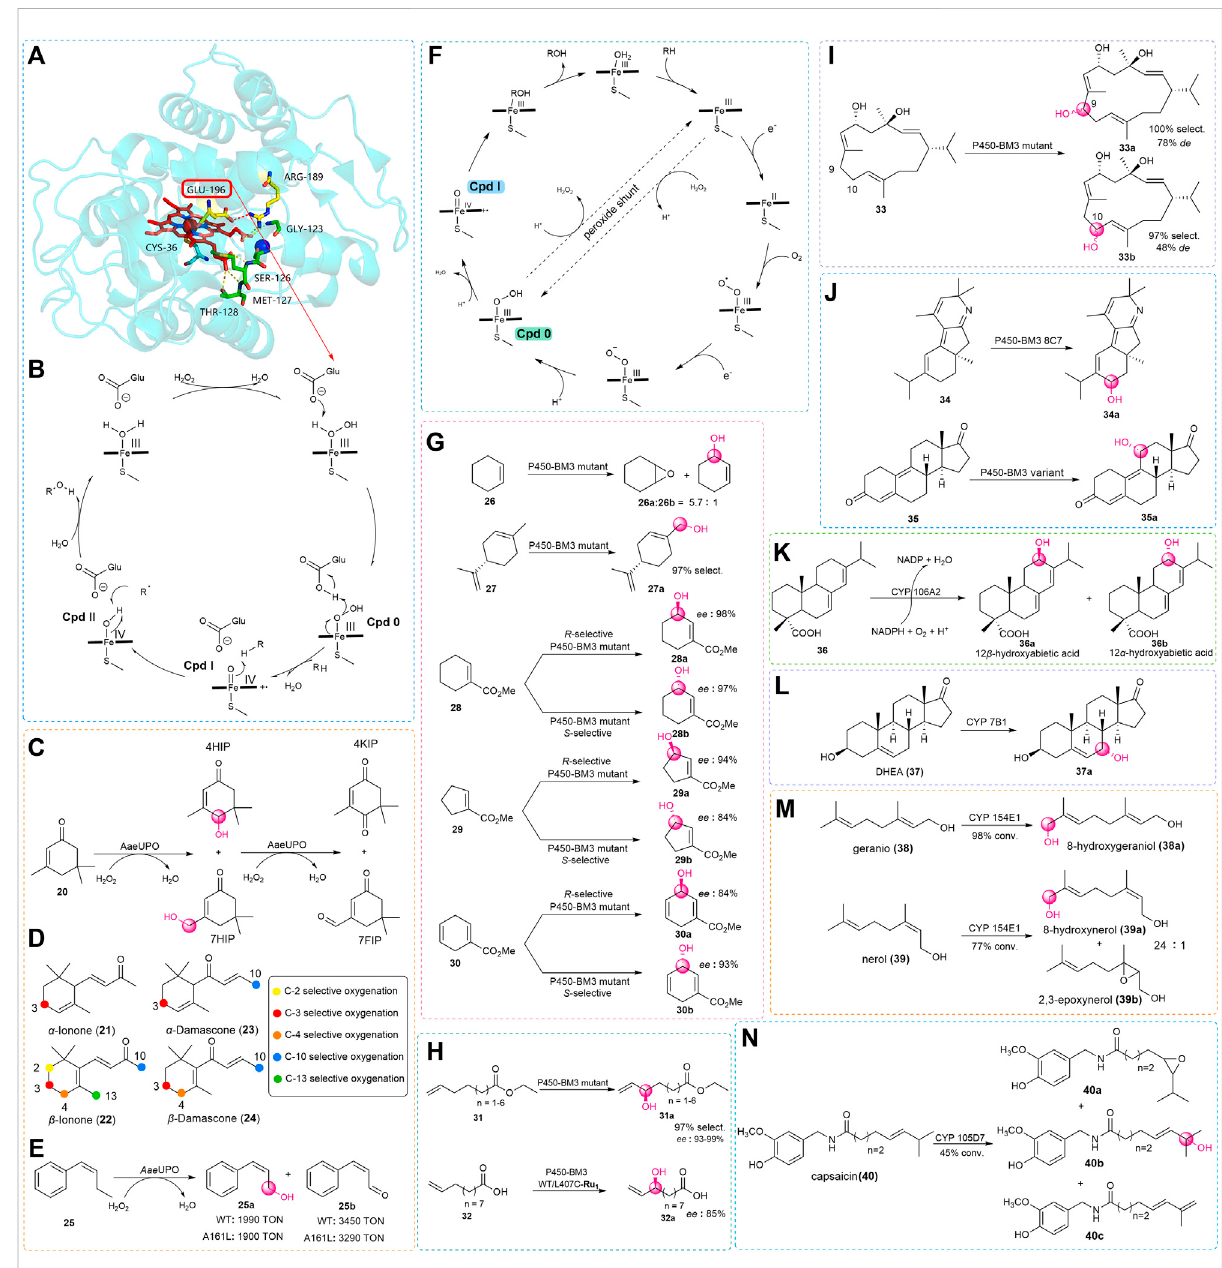
FIGURE 2 (A) Overall crystal structure of Aae APO (Wang et al., 2017). (B) Catalytic mechanism of Aae APO. (C) Isophorone hydroxylation and hyperoxidation catalyzed by Aae UPO. (D) Different colors indicate the positions where the substrate may be hydroxylated during UPO catalysis, obtaining the different oxygenatedderivatives. (E) Bioconversionofthe Mth UPOmutantA161Lgainstheallylicoxidationproducts. (F) OxidationreactionmechanismofP450s.